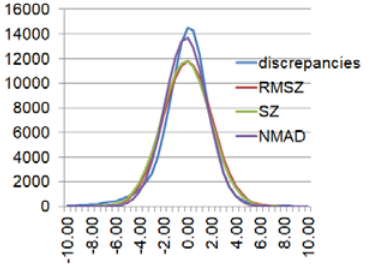
Figure 12. Frequency distribution of AW3D30 discrepancies improved by ZFIT and filtered against LiDAR